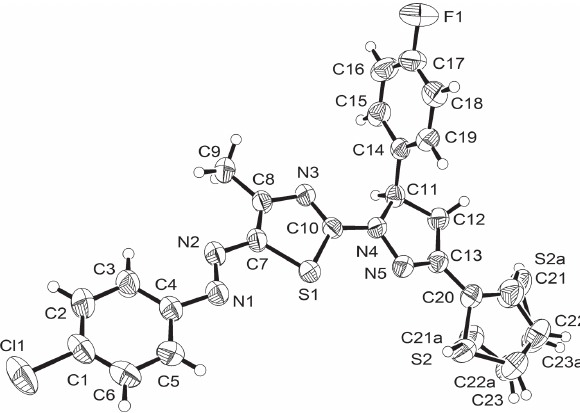
Table 1: Data collection and